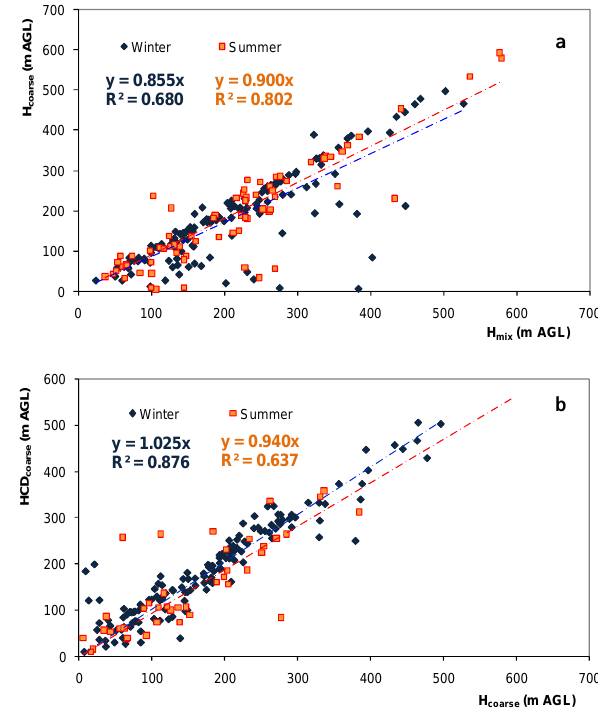
Fig. 7. The linear correlation between H mix and H coarse (a) , and between H coarse and HCD coarse (b) in the winter (DJF months; N profiles=142) and summer (JJA months; N